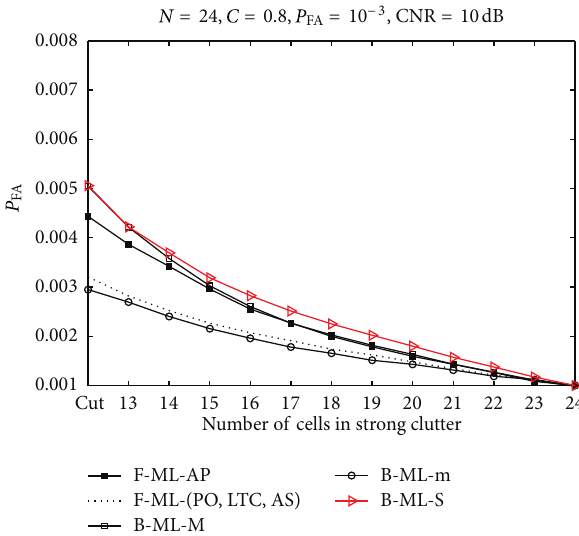
F 9: Detection performance of distributed detector based on ML CFAR algorithm versus number